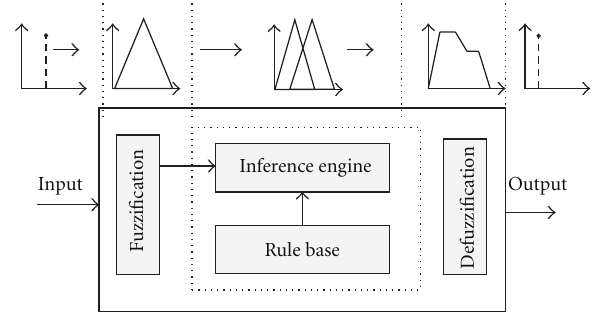
Figure 2: Fuzzy inference